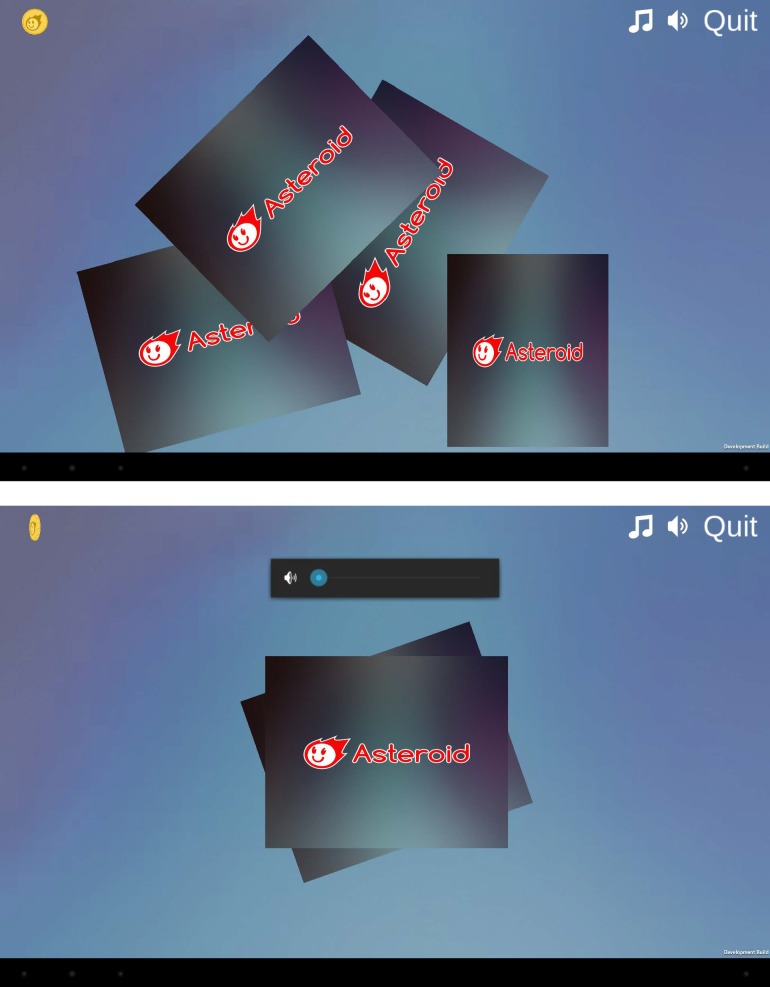
Screenshots from the animation showing the four stimuli being shuffled and dealt out again as a cue to the random stimulus location.